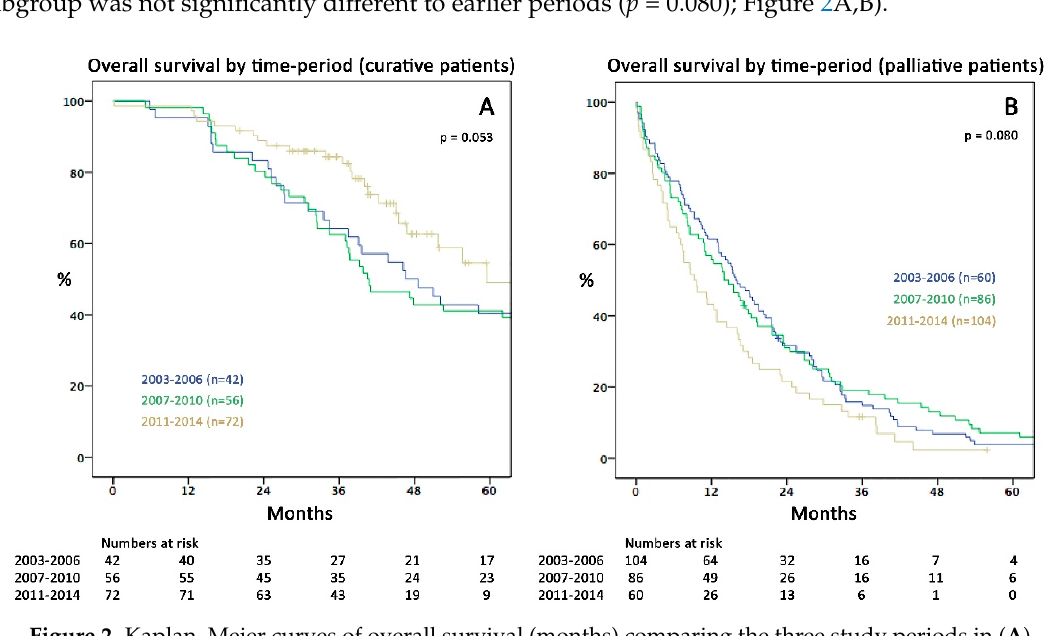
Figure 2. Kaplan–Meier curves of overall survival (months) comparing the three study periods in ( A